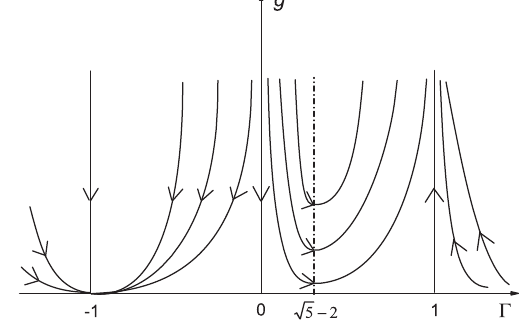
FIG. 1. The RG flow in the Γ - g parameter space for anisotropic driven Bose-Einstein condensation in d ¼ 2 . For Γ < 0 and g > 0 , all flow lines go to a stable fixed point ð − 1 ; 0 Þ ; for Γ > 0 and g > 0 , all flow lines go to infinity and approach the isotropic limit Γ ¼ 1